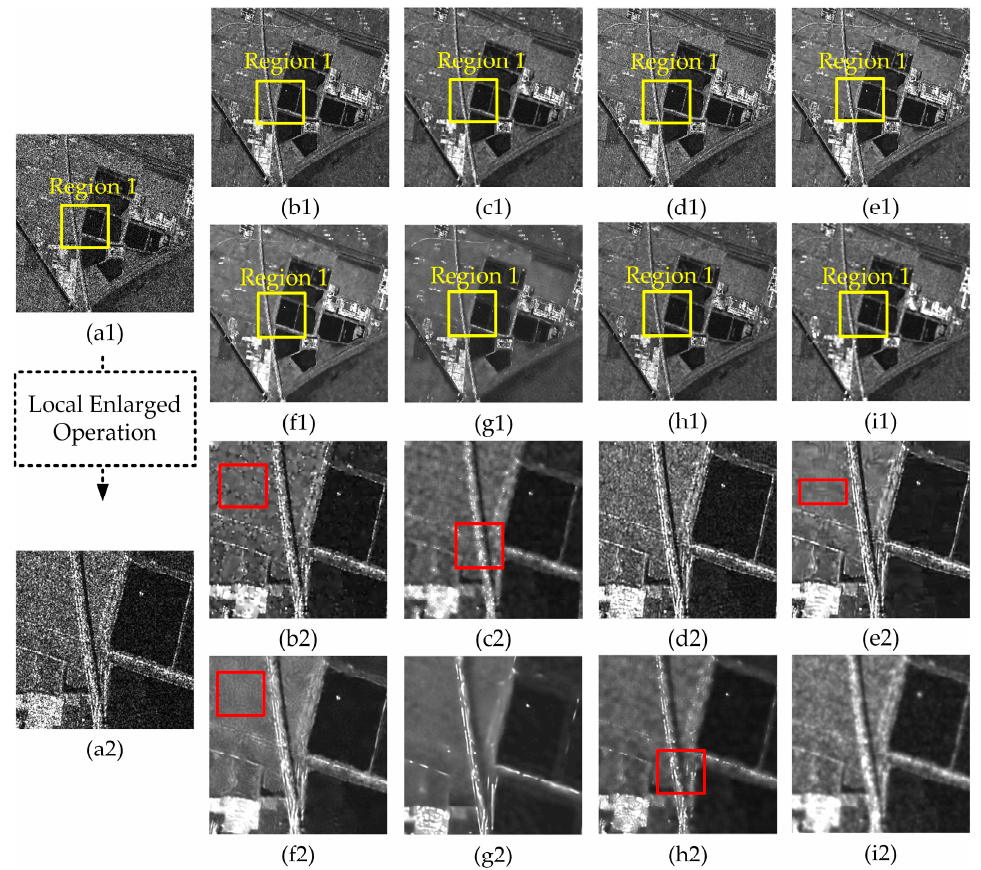
Figure 10. ( a1 ) TerraSAR-X original image. Images filtered by ( b1 ) DPAD, ( c1 ) EnLee, ( d1 ) SAR-BM3-D, ( e1 ) FANS, ( f1 ) PPB, ( g1 ) DnCNN, ( h1 ) NL-means, and ( i1 ) MDLPIA-NLM filters. ( a2 – i2 ) Locally enlarged images of region 1 of ( a1 – i1 ), respectively. The red box and circle are areas for further observation.